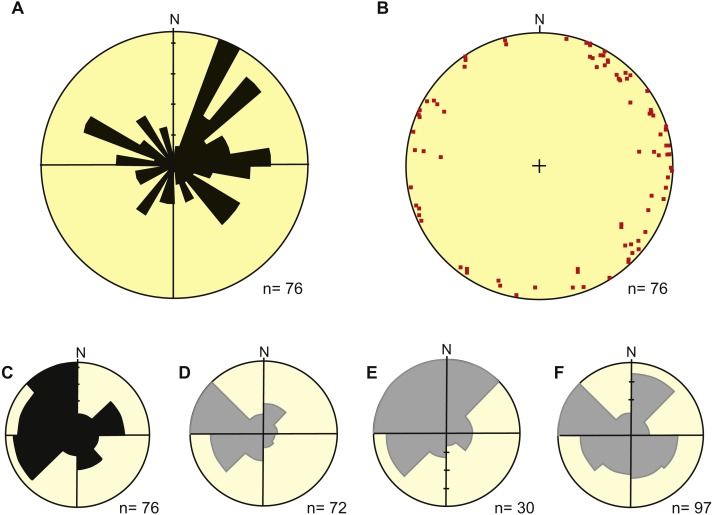
Orientation of fossil burrows compared with modern data from dasypodid burrows.(A) Rose diagram showing the dip azimuth of fossil burrows. (B) Equal area projection of dip azimuth and dip angle of fossil burrows. (C) Entrance orientation of fossil burrows, assuming that it is located at 180°of measured dip azimuth. The data in A–C is from SG and LLP localities, those from the remaining locality are preserved only in cross-section. (D) Entrance orientation of several species of dasypodid burrows from semiarid settings of northern-central Argentina build from data by Crespo (1944). (E) Entrance orientation of Dasypus hibridus burrows from a grassland setting in Uruguay build from data by González, Soutullo & Altuna (2001). (F) Entrance orientation of Chaetophractus villosus burrows from cultivated land in Buenos Aires province, Argentina build from data by Abba, Udrizar & Vizcaíno (2005). Image credit: Ricardo Néstor Melchor.